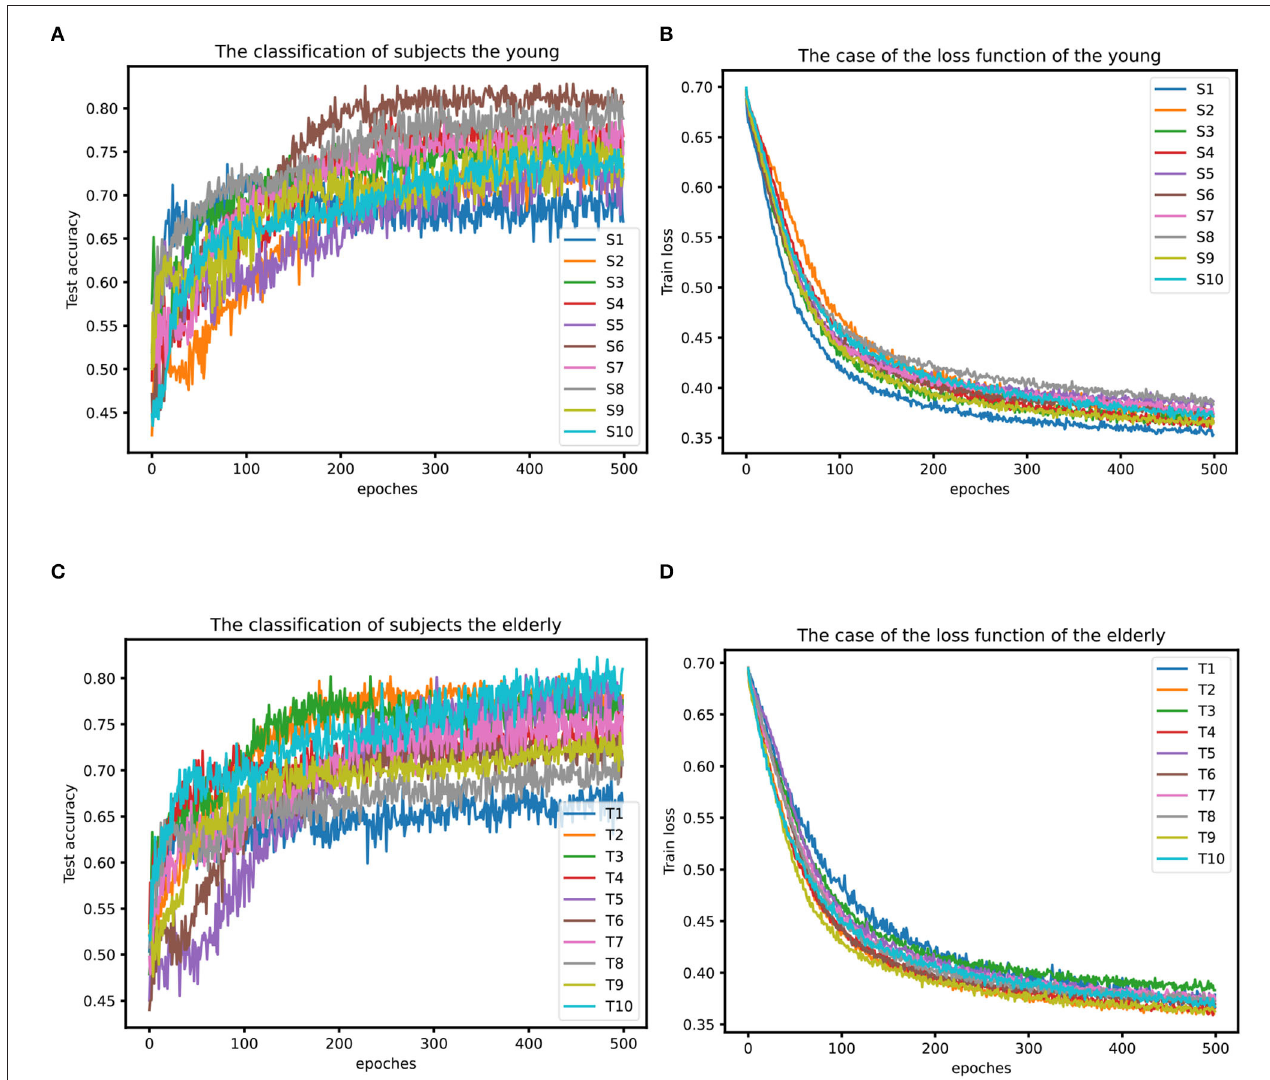
FIGURE 11 | (A) Classification results of the young. (B) Loss function situation of the young. (C) Classification results of the elderly. (D) Loss function situation of the